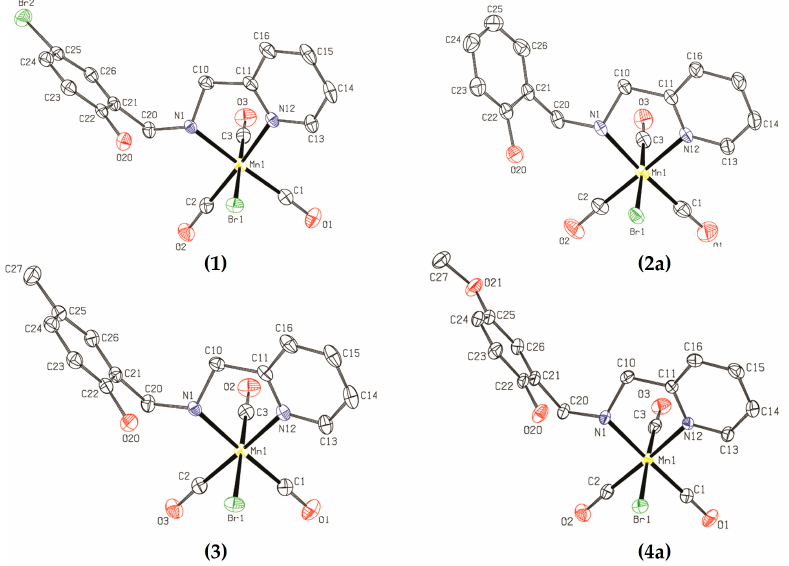
Figure 2. ORTEP plots of organometallic compounds ( 1 )–( 4 ) with ellipsoids drawn at a 50% probability level. Hydrogen atoms were omitted for clarity. Structures ( 2a ) and ( 4a ) were selected from the conformers and isomers, respectively. See ( 2b ) and ( 4b ) in Figure S7; gray = carbon, red = oxygen, green = bromide, blue = nitrogen, and yellow = manganese.